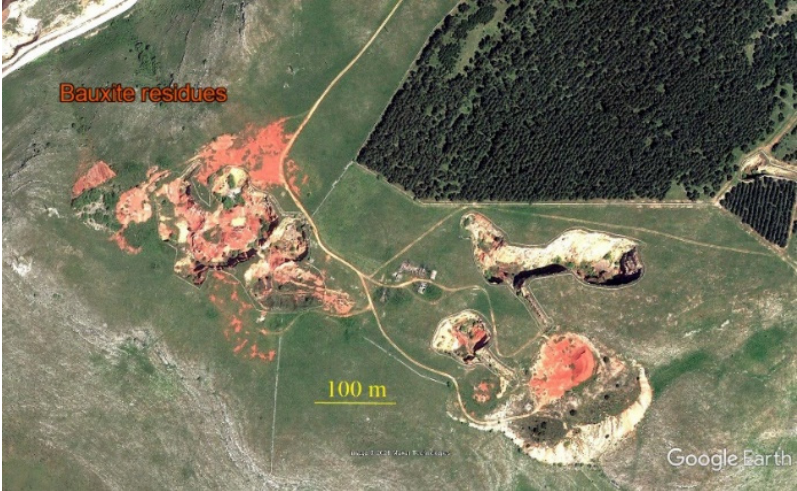
Figure 2. The bauxite mining residues located in Apulia (Google Earth Image, 12 April